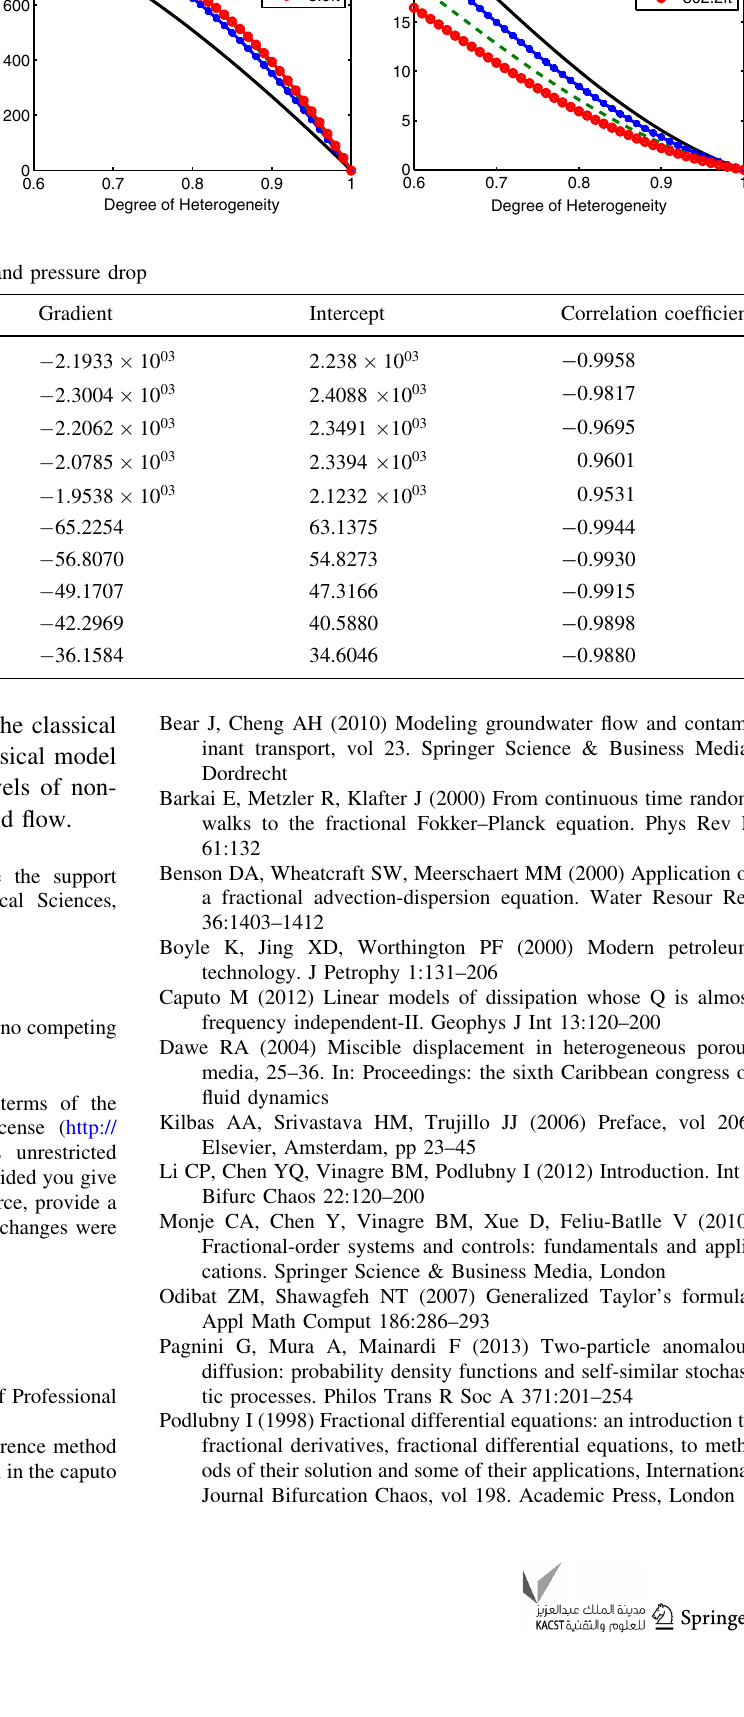
Fig. 5 Fractional radial diffusivity model shows decreased p wf for variation in a at 12 h